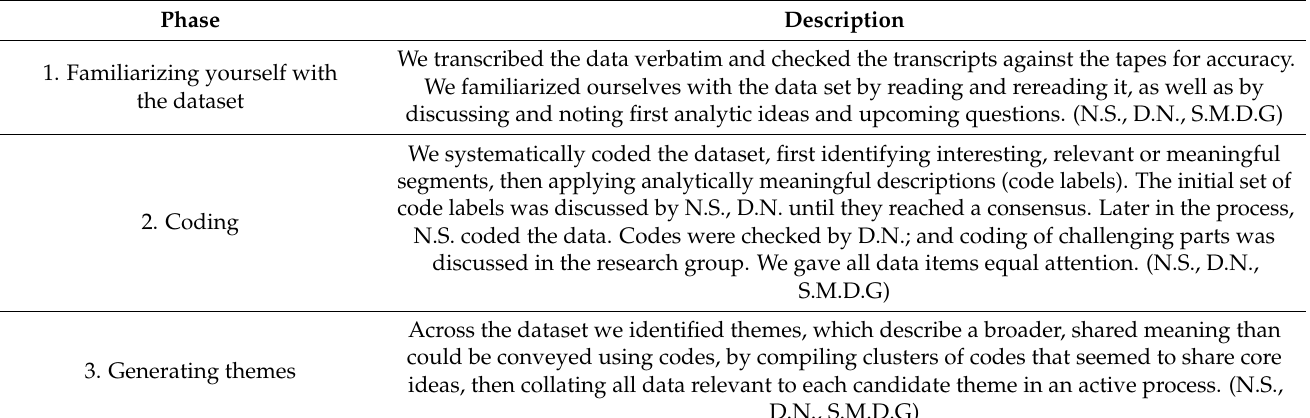
Table 2. Description of data analysis along the six phases of reflexive thematic analysis [28]. Phase